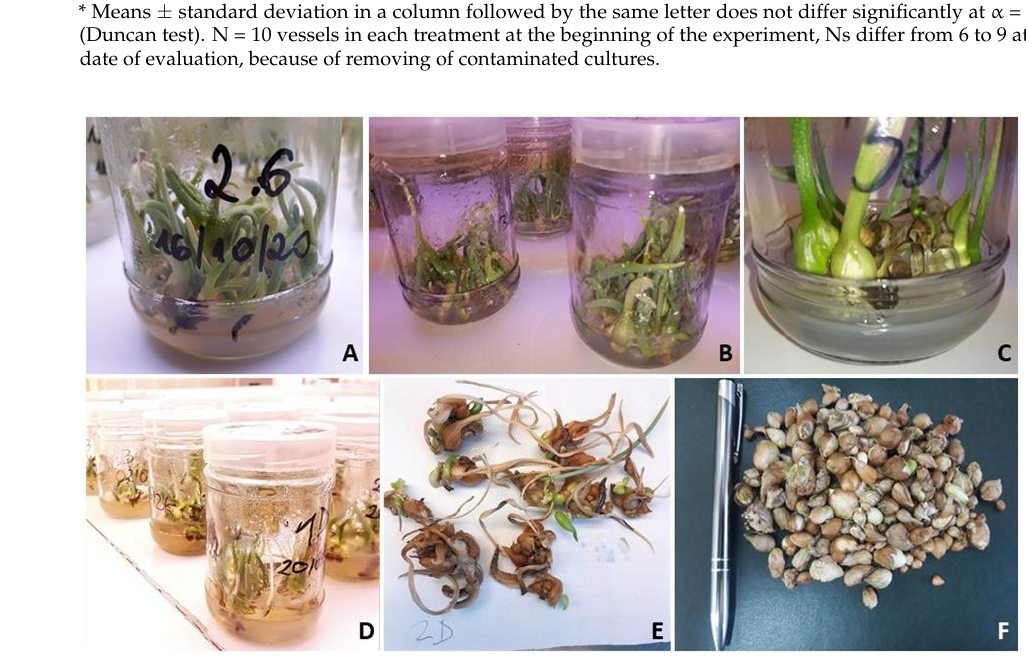
Figure 1. Different micropropagation stages of the tulip cultivar ‘Heart of Warsaw’: ( A ) Shoot multiplication on MS medium with glucose; ( B ) no or very limited bulb formation on the control medium without liquid phase; ( C ) start of microbulbs forming on the two-phase medium with fructose and paclobutrazol; ( D ) cultures on two-phase medium, the preparatory stage for bulbing, Experiment 3; ( E ) microbulbs obtained on medium supplemented with glucose and paclobutrazol which are mostly mature, surrounded by a dry covering scale; ( F ) matured microbulbs.